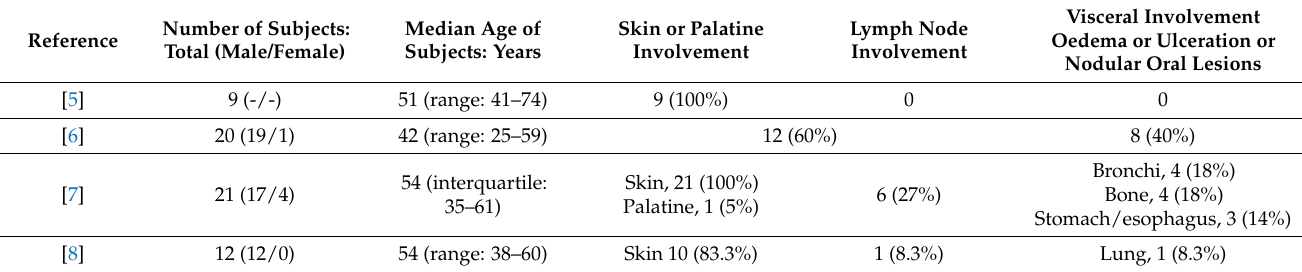
Table 2. Clinical presentation of Kaposi’s sarcoma in HIV-patients with suppressed viremia in main published series.